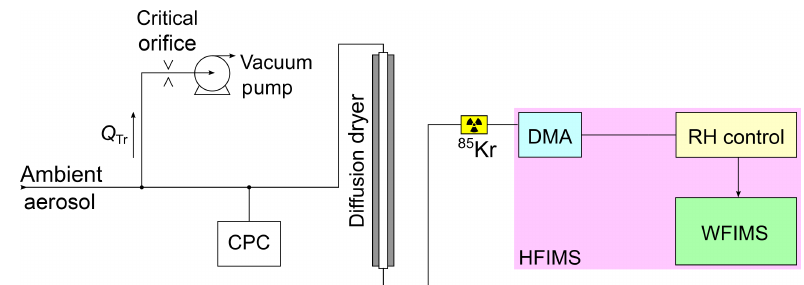
Figure 4. Experimental setup for measuring hygroscopic growth of ambient particles.